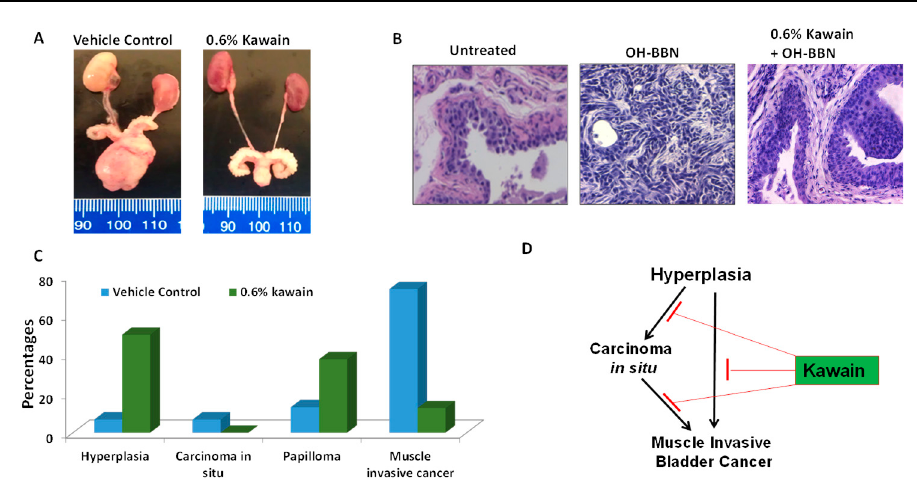
Figure 3. Dietary feeding of kawain inhibits the progression of hyperplasia to carcinoma in situ and muscle-invasive bladder tumors. ( A ) A representative photograph of representative genitourinary systems from mice fed with a vehicle diet or a diet supplemented with 0.6% kawain. ( B ) Microscopic examination of H&E-stained bladder tissues from mice treated with the control diet, OH-BBN only, and OH-BBN plus the kawain diet. Magnification: 200×. ( C ) Percentages of hyperplasia, carcinoma in situ, papilloma, and muscle-invasive cancer in mice exposed to OH-BBN and treated with a vehicle control diet or a diet supplemented with 0.6% kawain. ( D ) Schematic presentation of the effect of the kawain diet on the pathological progression of OH-BBN-induced urinary bladder cancer in mice.